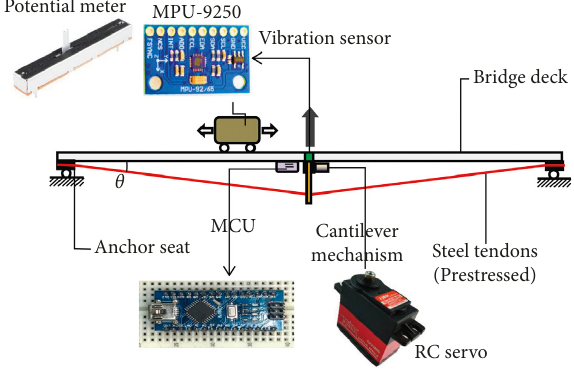
Figure 1: Prototype and control instruments of this proposed NEM as a virtual pier of a